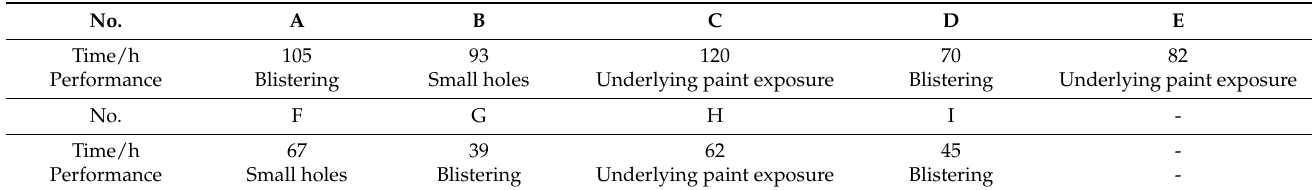
Table 11. Results for Design 1 (alkali resistance).